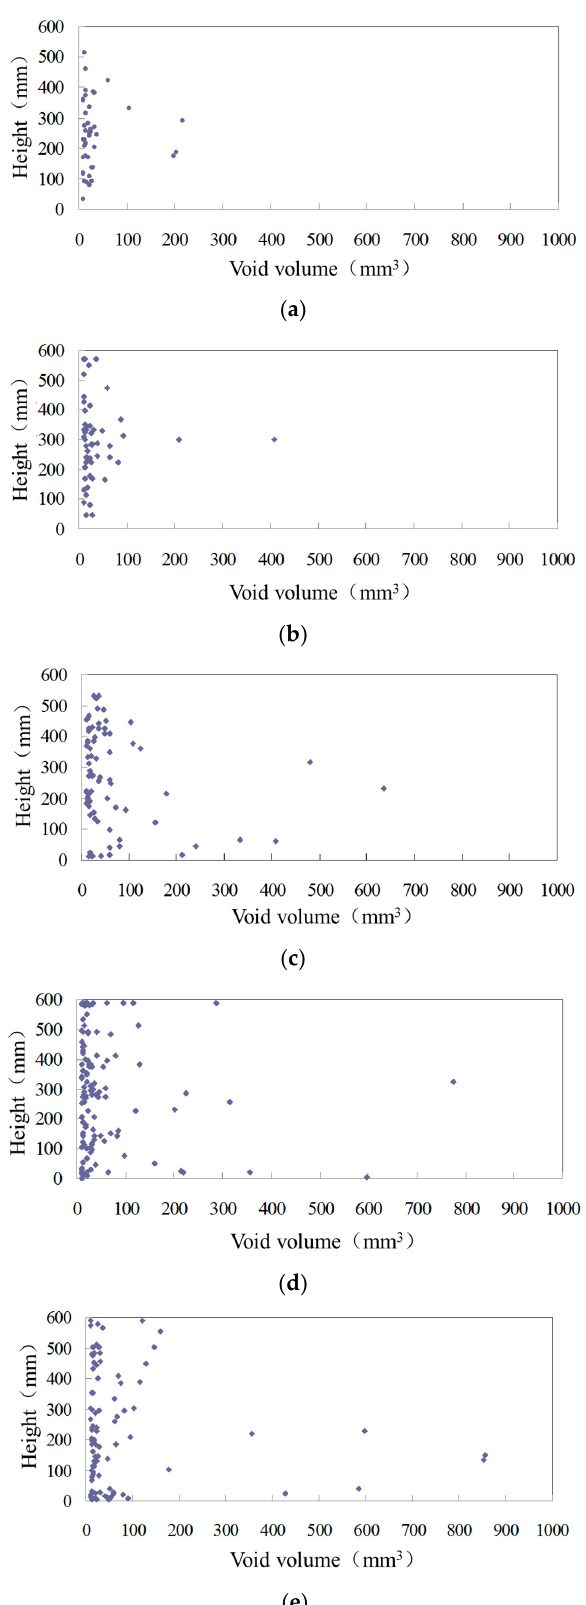
Figure 5. 1–10 mm 3 void distribution of asphalt mixture. ( a ) 80 °C; ( b ) 90 °C; ( c ) 120 °C; ( d ) 140 °C; ( e ) 150 °C.